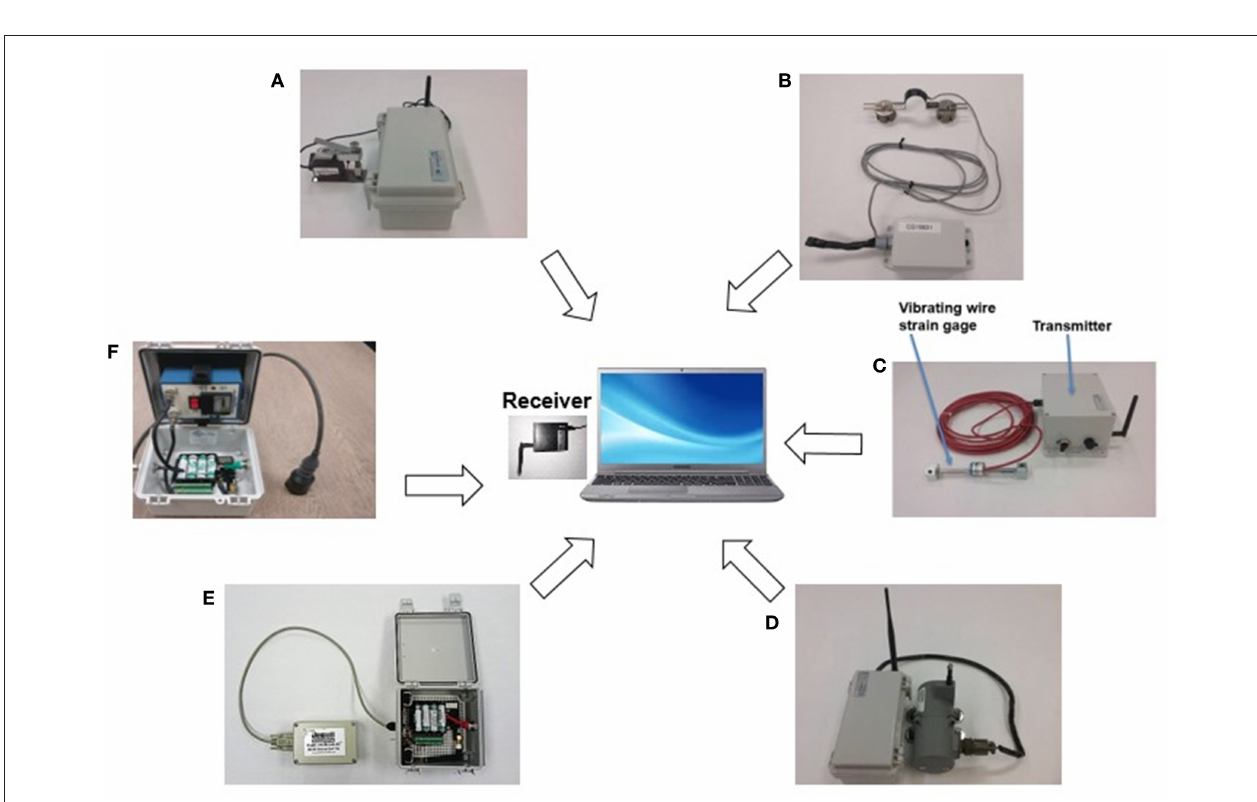
FIGURE 7 | Suite of traditional proven sensors transformed for wireless operation, (A) Wireless magnetic strain gage, (B) Wireless clip gage (crack meter, strain), (C) Wireless vibrating wire strain gage, (D) Wireless displacement gage, (E) Wireless tiltmeter, (F) PCB wireless accelerometer.